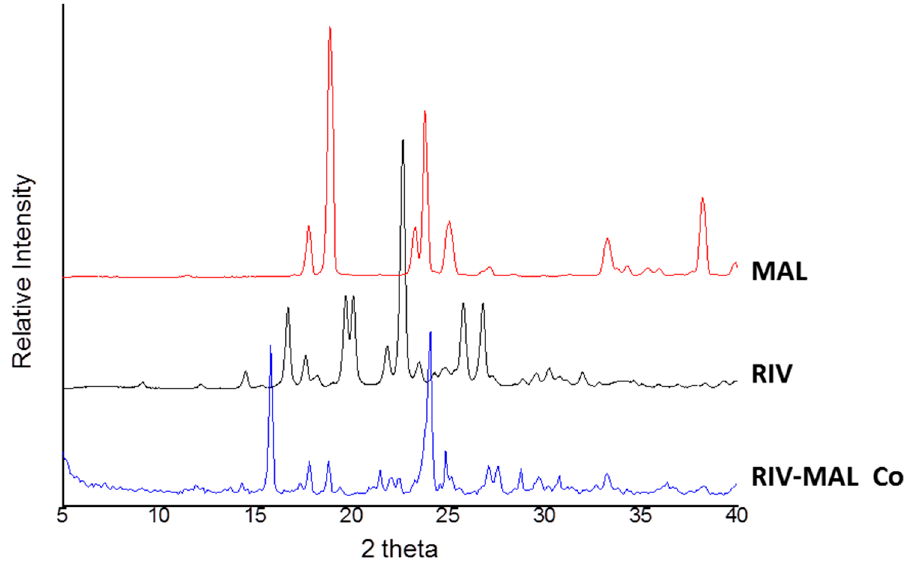
Figure 3. Overlay of XRPD di ff ractograms for RIV, MAL, and RIV-MAL Co Samples.